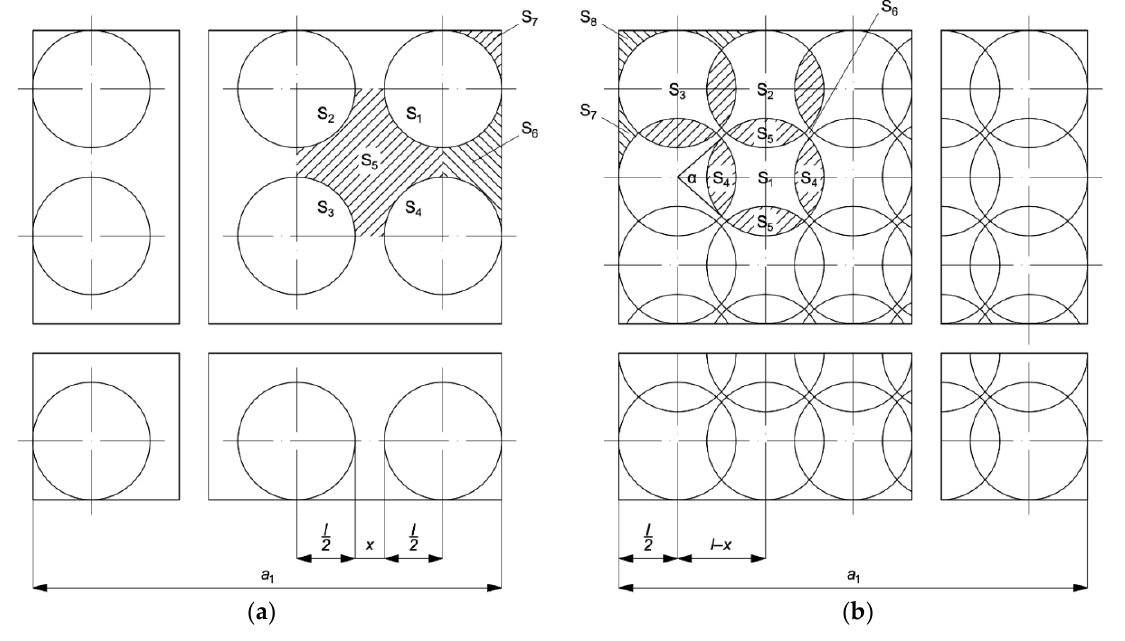
Figure 19. Models of the mixing process in a vortex layer: ( a ) the case when the zones of rotation of ferromagnetic elements do not intersect; ( b ) the case when the rotation zones of ferromagnetic elements intersect.